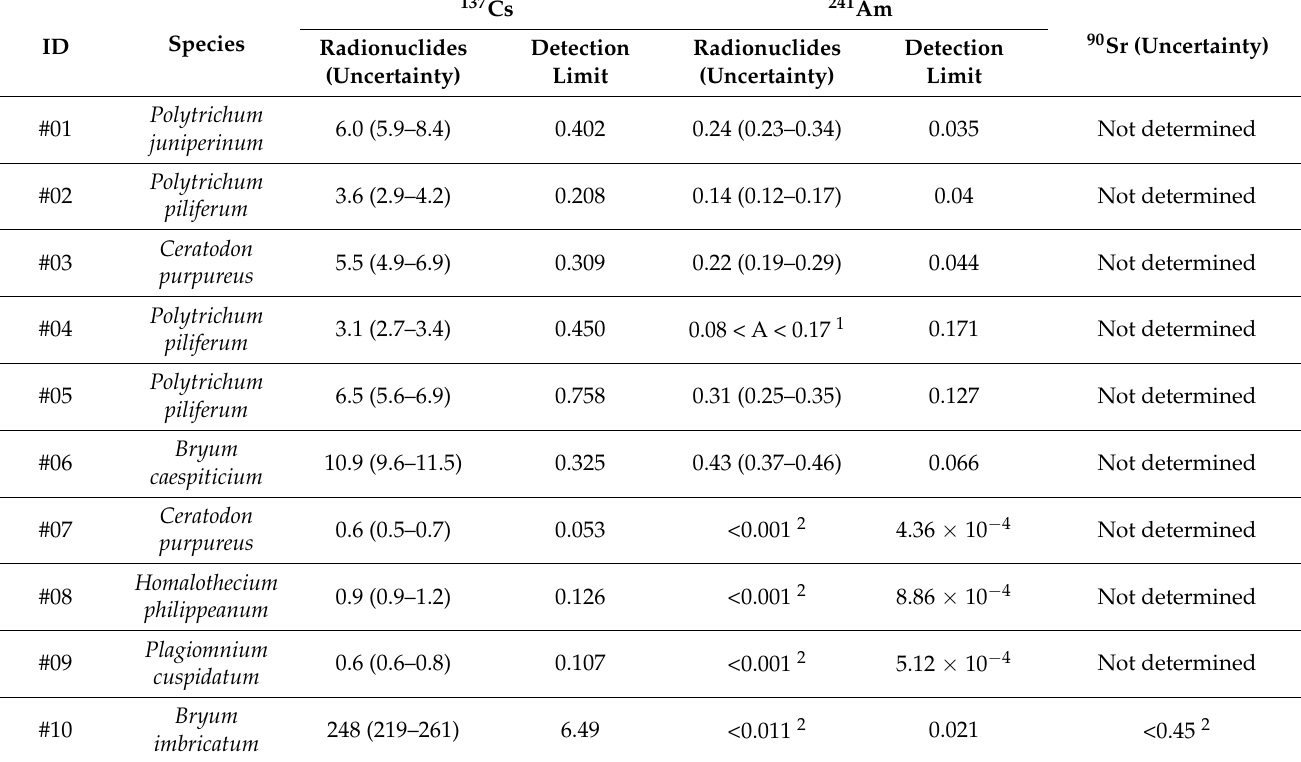
Table 2. Concentration of selected radionuclide in bryophytes [Bq/g]; # indicates the sampling location as described in Figure